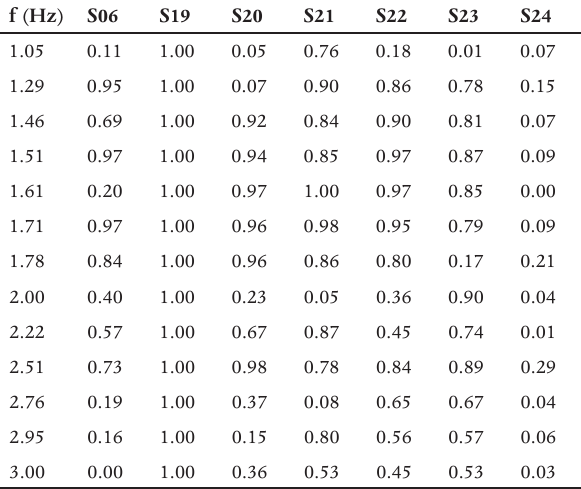
Table 4. Phase factor (°) in C2 with reference to S04.